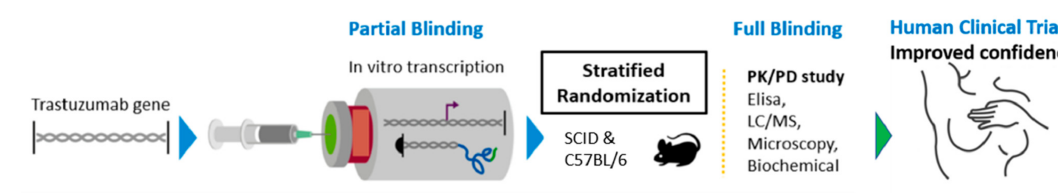
Figure 1. Schematic overview of the preparation and clinical validation of TZM antibodies encoded by